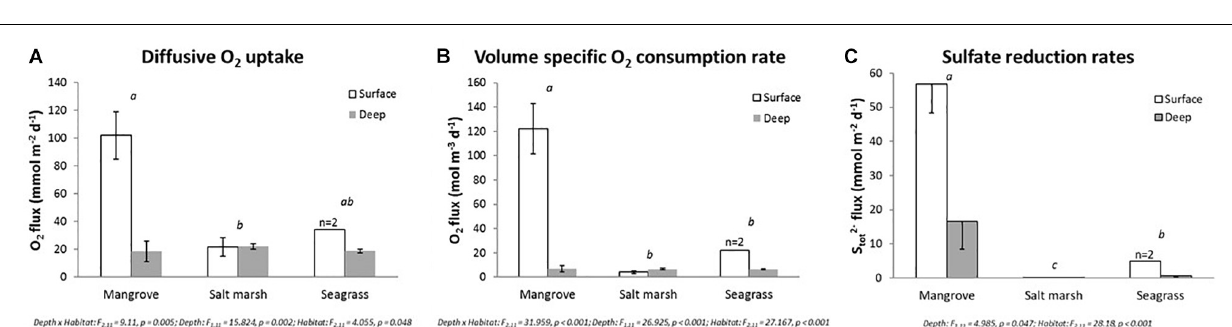
FIGURE 4 | Oxygen consumption and sulfate reduction rates in VCHs. (A) Diffusive O 2 uptake rates (DOU; in mmol m − 2 d − 1 ) in surface (“surface”; 0–10 cm) and deeper (“deep”; > 50 cm depth) sediment layers of sediments originating from mangrove, salt marsh, and seagrass ecosystems (Sydney area, NSW, Australia). Rates are calculated from the measured O 2 microprofiles. (B) Volume-specific O 2 consumption rates (R; in mmol m − 3 d − 1 ) in surface (“surface”; 0–10 cm depth) and deeper (“deep”; > 50 cm depth) sediment layers of sediments originating from mangrove, salt marsh, and seagrass ecosystems (Sydney area, NSW, Australia). Rates are calculated from the measured O 2 microprofiles divided by the O 2 penetration depths. (C) Estimated sulfate reduction rates (in mmol m − 2 d − 1 ) in surface (“surface”; 0–10 cm depth) and deeper (“deep”; > 50 cm depth) sediment layers of sediments originating from mangrove, salt marsh, and seagrass ecosystems (Sydney area, NSW, Australia). The estimated sulfate reduction rates are calculated based on the flux of total sulfide (S tot 2 − ) calculated from the measured H 2 S and pH microprofiles, as shown previously by Kühl and Jørgensen (1992). Rates are mean values ± SEM; n = 6–9, technical replicates (biological replication of 2–3). Letters indicate statistical difference between ecosystem type (main